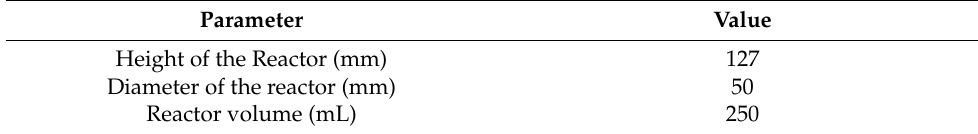
Table 2. Geometrical parameters of the fix bed reactor